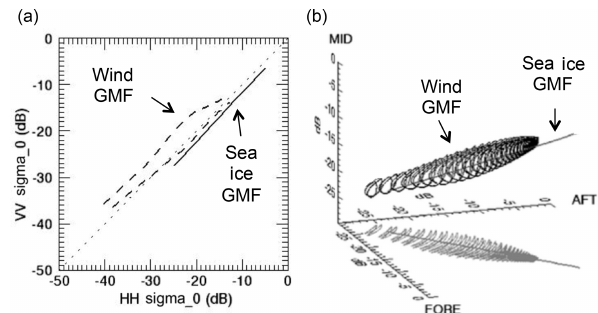
Figure 3. Ocean wind and sea ice geophysical model func- tions (GMFs) in the scatterometer measurement space: QuikSCAT (a) and ERS ASCAT (b) . Plots adapted from Bel- monte Rivas and Stoffelen (2011) and Belmonte Rivas et al.